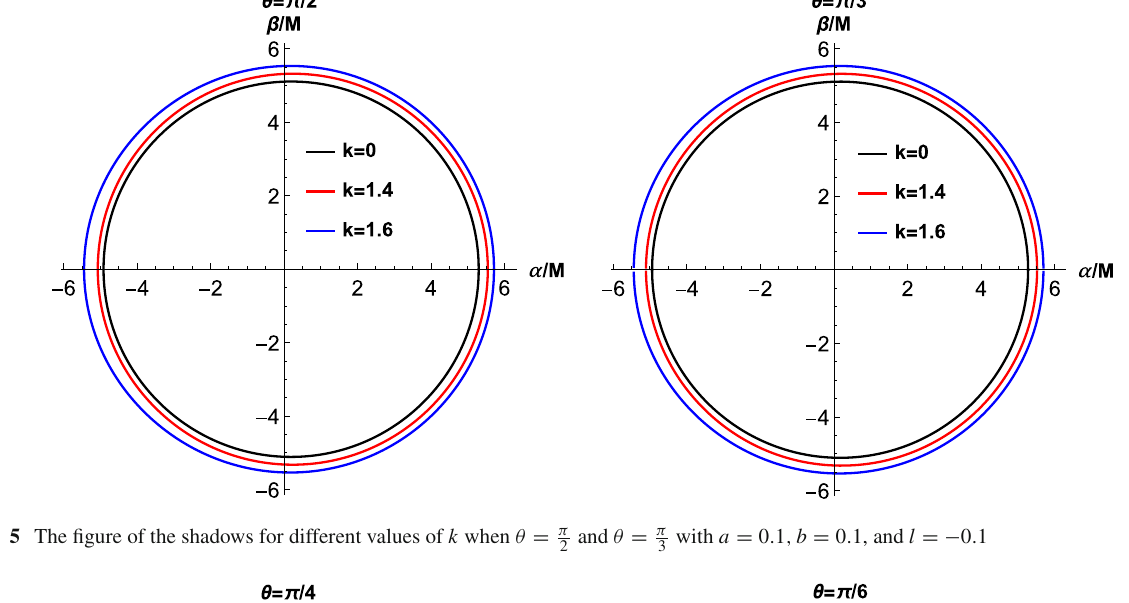
Fig. 5 The figure of the shadows for different values of k when θ = π